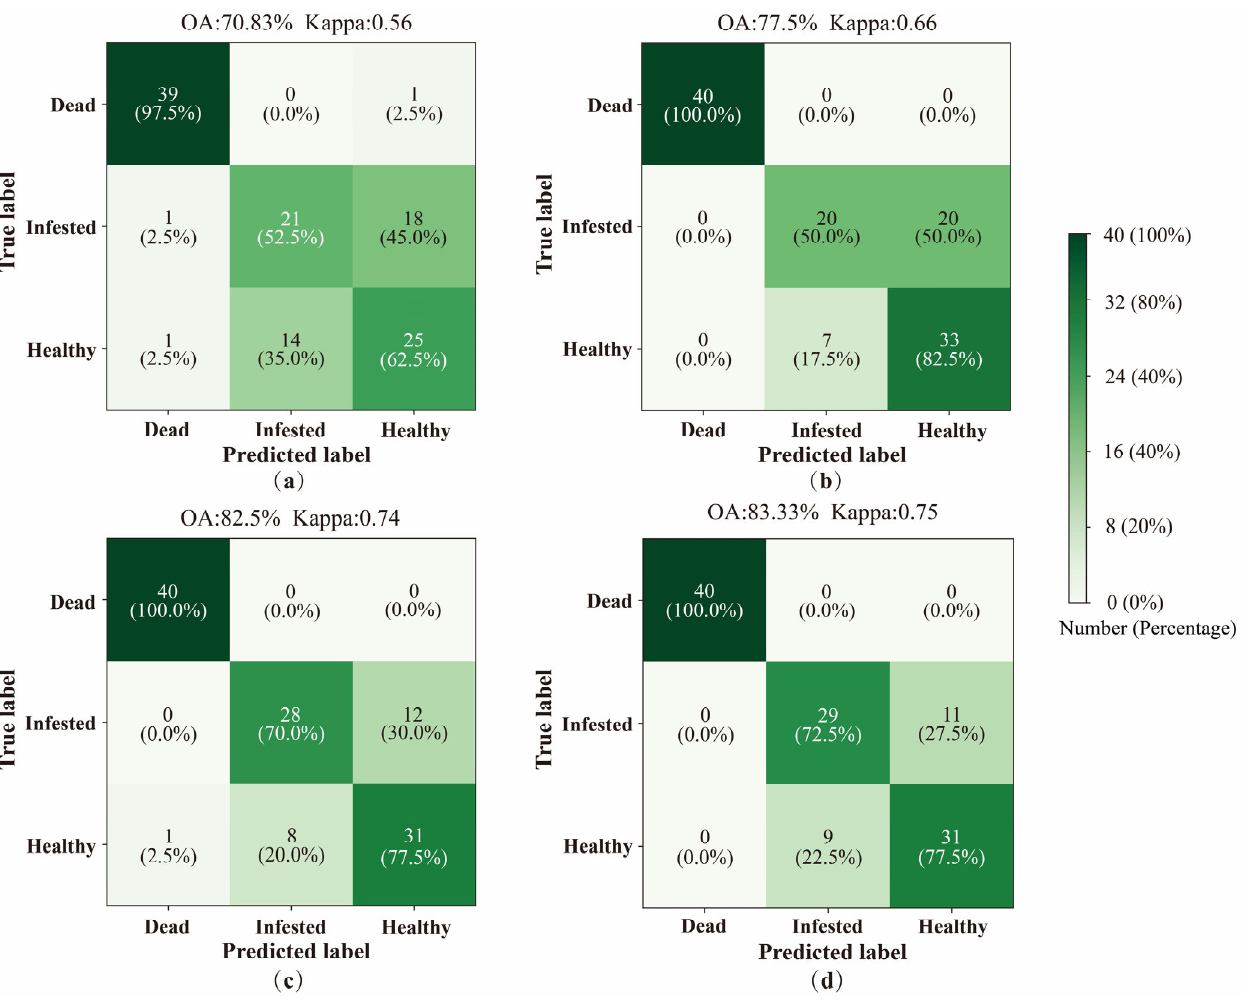
14 of 21 Table 3. Parameters of the RF models with different input variables. Model